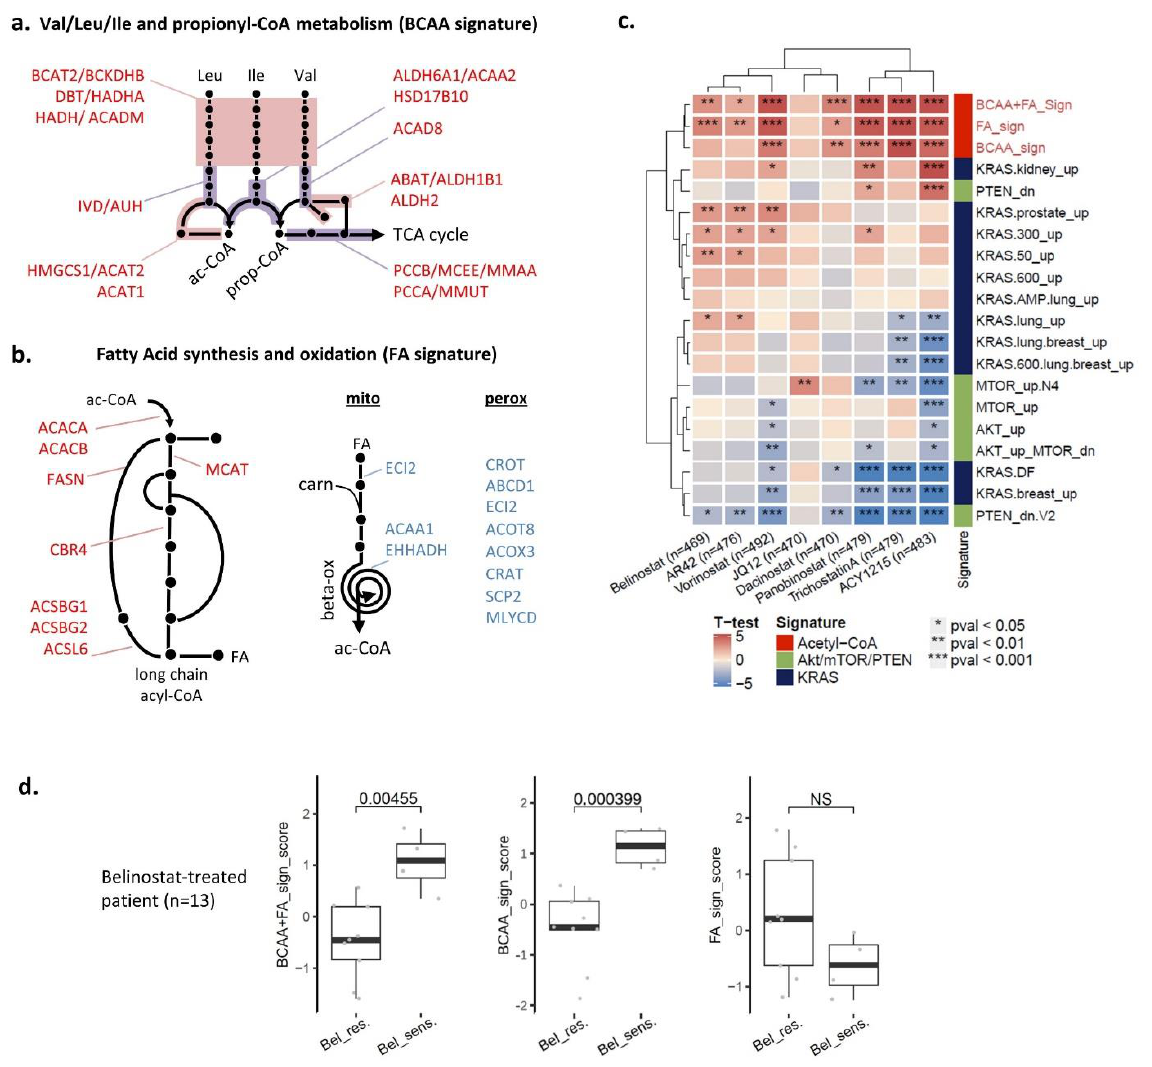
Figure 6. Two acetyl-CoA metabolism pathways are markers of HDAC inhibitor sensitivity. ( a , b ) Key acetyl-CoA metabolic pathways involved in response to eight HDAC inhibitors were selected by elastic net analysis in CCLE panel (see supplementary Figure S7). Leading-edge genes for the acetyl-CoA pathways were overlaid onto pathway representations, with upregulated genes in red and downregulated genes in blue. ( c ) Three gene signatures were derived from the two pathways and signature scores were calculated in CCLE panel by weighted averaged expression using both up- and down-regulated genes. KRAS activation signatures were also calculated by the same method using the C6 collection in the Molecular Signatures Database. Significant differences for all signature scores between resistant versus sensitive cell lines were calculated by Welch’s t -test in CCLE panel for eight HDACis, and results were plotted in a heatmap. Numbers in parentheses indicate the number of cell lines tested for each HDACi. ( d ) Acetyl-CoA Signature scores were plotted (boxplot with individual data point) according to response to Belinostat in AML patients (independent cohort). Statistical significance between groups was assessed using unpaired two-tailed Student’s t - test (NS stands for “not significant”).